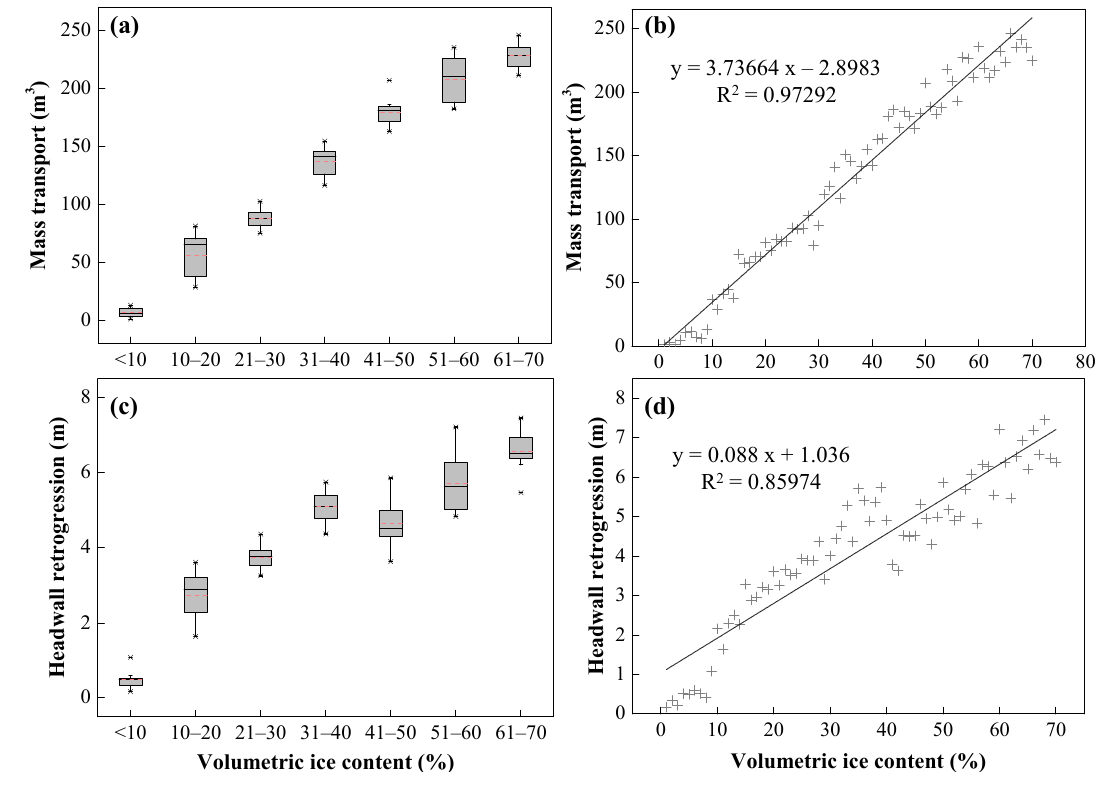
Figure 13. Mass transport, headwall retrogression, and relation with volumetric ice content. ( a ) Box plots of volumetric change in K1129W thaw slump development area of different volumetric ice contents. ( b ) Linear relation between mass transport amount and volumetric ice content. ( c ) Box plots of headwall retrogression in K1129W thaw slump development area of different volumetric ice contents. ( d ) Linear relation between headwall retrogression and volumetric ice content. Note that the red short dash is the average value.